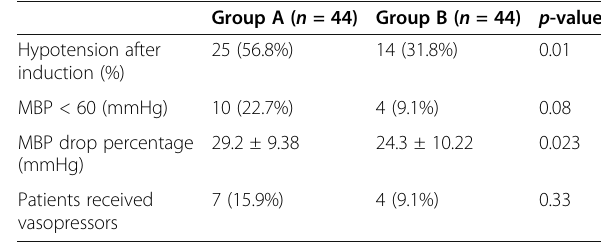
Table 3 Comparison of HR values at basal and after anesthesia induction between the two study groups Group A ( n = 44)